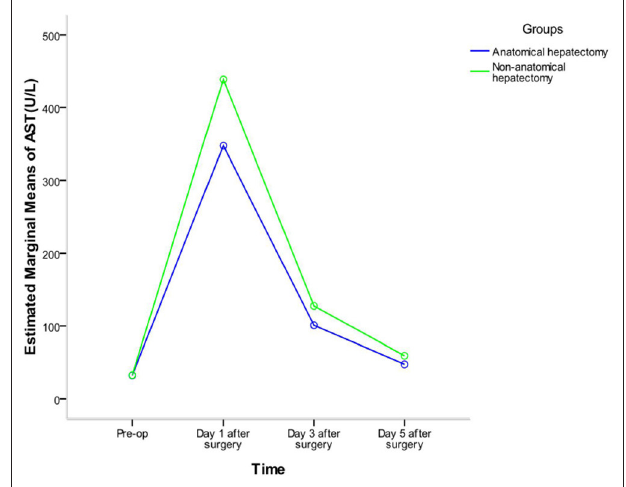
FIGURE 4 | Interactive profile of time factor and grouping factor.